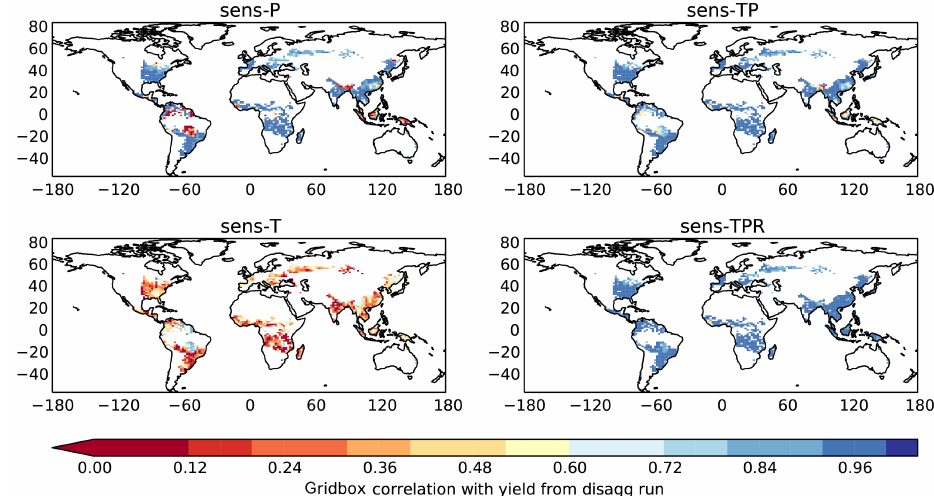
Figure 2. The correlations between the annual maize yield in the disagg run and the annual maize yield from the sens-P (top left), sens-TP (top right), sens-T (bottom left) and sens-TPR (bottom right) runs for each grid box.